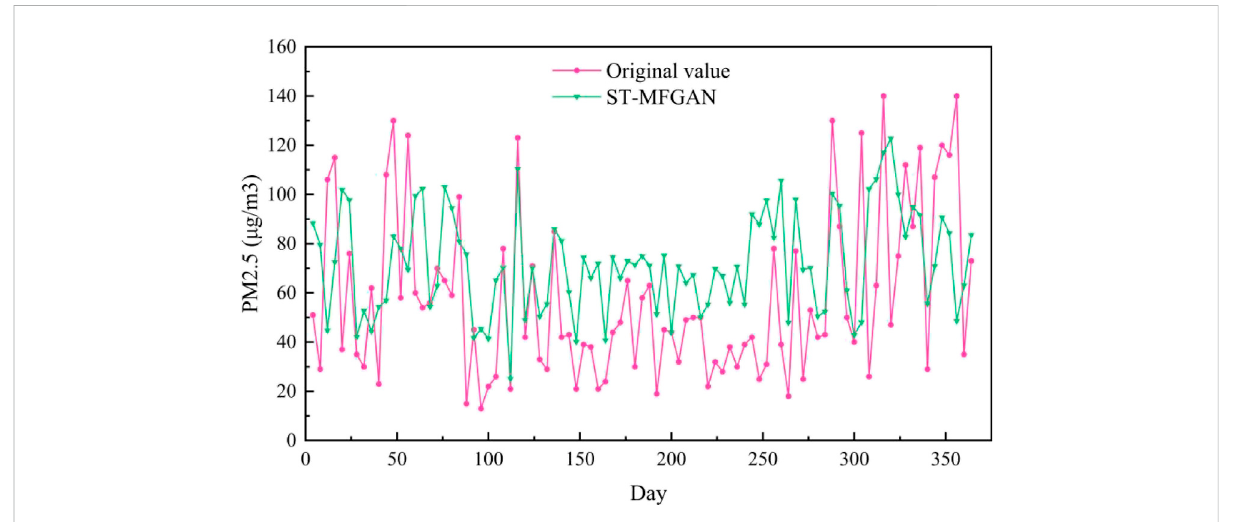
FIGURE 13 Experimental results of ST-MFGAN method in Baoding test set.